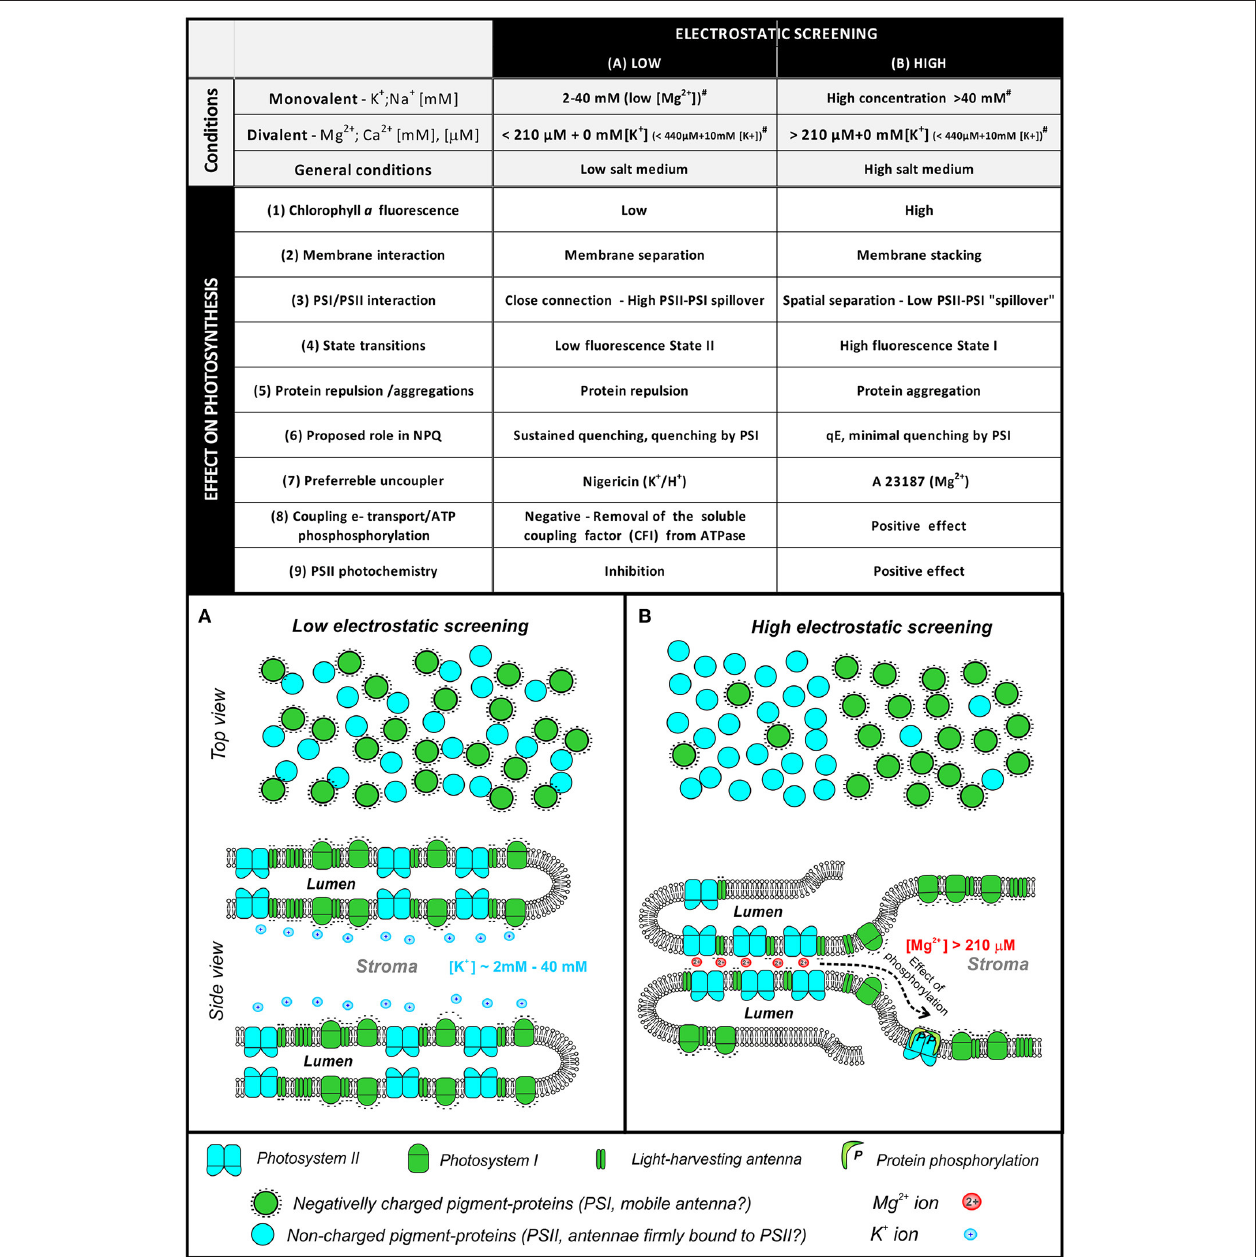
FIGURE 5 | A simplified scheme of changes in protein organization in different states of electrostatic screening (adapted from Barber, 1980b). The table summarizes basic conditions for low or high screening—high screening is induced by high divalent cation content [e.g., > 220 µ M Mg 2 + with no (K + ), > 440 µ M Mg 2 + with 10 mM (K + ), see (Mills and Barber, 1978) for details]. The switch between low/high screening mode is a complex interplay between monovalent/divalent cation concentrations as it is described by EDL model of thylakoid membrane (Barber et al., 1977). The low/high screening state is then reflected in various physiological processes including intensity of Chl a fluorescence (low intensity /high intensity), thylakoid membrane stacking or separation, lower/high excitation spillover between photosystems, State II/State I, protein repulsion/aggregation, proposed role in non-photochemical quenching, preferable uncouplers (Mg 2 + ionophore A23187 vs. K + /H + antiporter nigericin), effect on electron-proton coupling in photophosphorylation, effect on PSII photochemistry. The screening is caused by ion attachment to membranes that results in screening of the electric-field of the membrane charge (i.e., damping of electrostatic field of fixed charges caused by the presence of interacting ions). (A) . Simplified scheme of membrane protein organization in the state of low electrostatic screening. Green cycles represent negatively charged proteins (PSI complex, light harvesting antennas), cyan particles represent less charged PSII. Monovalent cation K + is shown as a dominant ion attached to the negatively charged membrane surface. (B) A simplified scheme of membrane protein organization in the state of high electrostatic screening, divalent cation, Mg 2 + , is proposed to be the main ion attached to the negatively charged membrane surface. Role of protein phosphorylation on protein redistribution is indicated ( # values were taken from Mills and Barber,